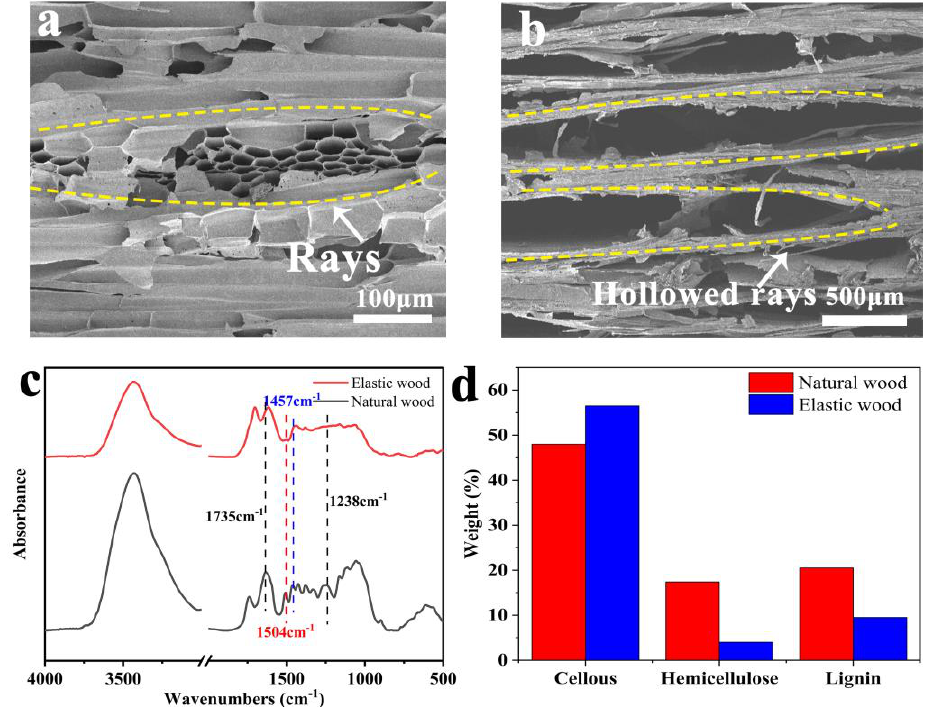
Figure 1. Structure and chemical evolution. ( a , b ) SEM images of tangential sections of natural wood and elastic wood. ( c ) FTIR spectra of the different wood samples. ( d ) Relative amounts of cellulose, hemicellulose and lignin in various samples of wood as determined by chemical composition.